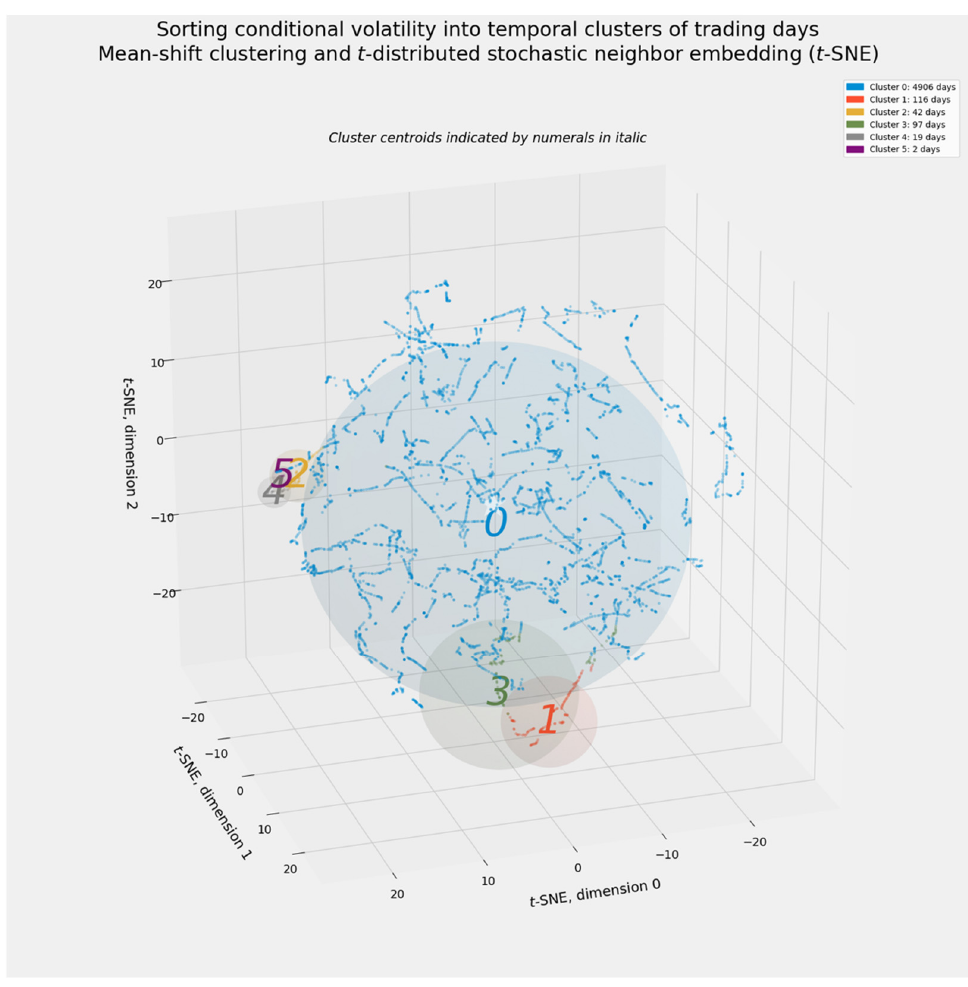
Figure 8. Mean-shift clustering of commodity markets—A t -SNE manifold.